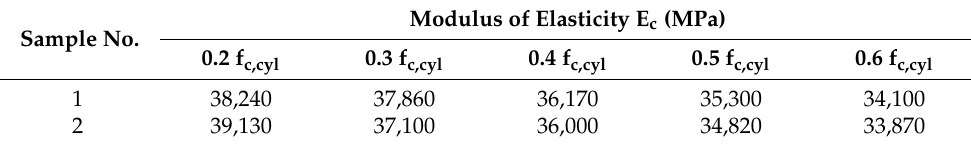
Table 2. Modulus of elasticity of concrete versus the level of loading. Sample